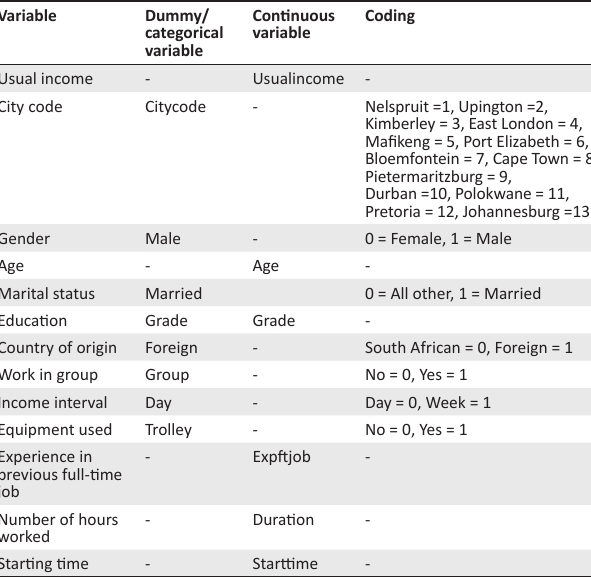
Country of origin